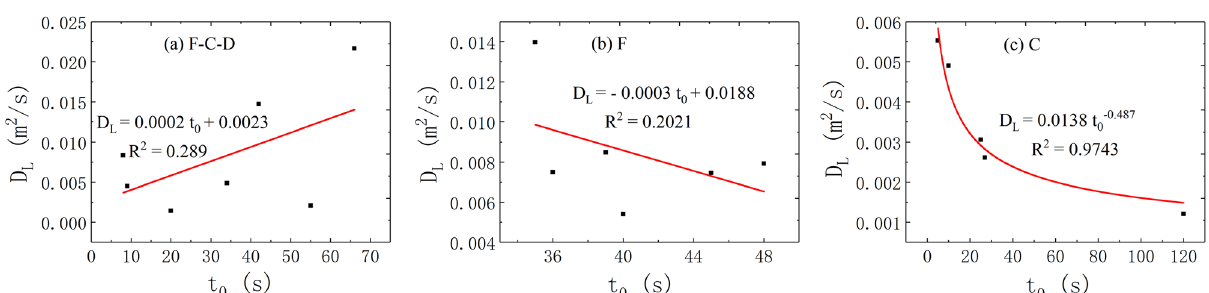
Figure 7. The correlation between the x and D L in different flow condition.